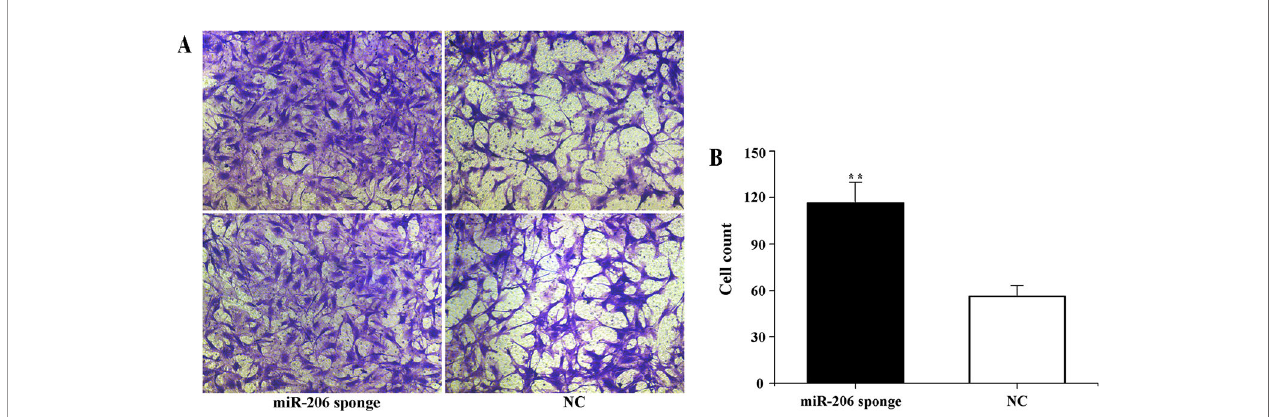
FIGURE 8 | Effect of miR-206 sponge on koi carp melanocytes migration. (A) Representative images (100 ) of migrated cells of miR-206 sponge were effectively increased compared with a miR-NC group. The cell density of the miR-206 sponge group was higher than the NC group. (B) The count number of invading cells using cell counter (** P <